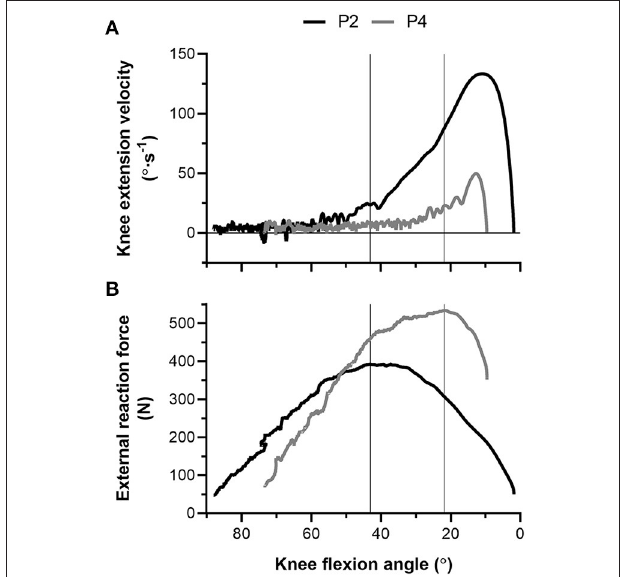
FIGURE 2 | (A) Left-sided knee extension velocity and (B) external reaction force-knee flexion angle traces during the Nordic hamstring exercise (NHE) trial with the highest peak force from two participants (P2, black; P4, gray). The vertical black (P2) and gray (P4) lines show the difference in knee flexion angle when peak force was attained between the two participants. Note the fluctuation in knee extension velocity around zero at more flexed knee angles during the NHE, and note the higher forces and lower knee extension velocities at more extended knee angles in the stronger participant (P4).